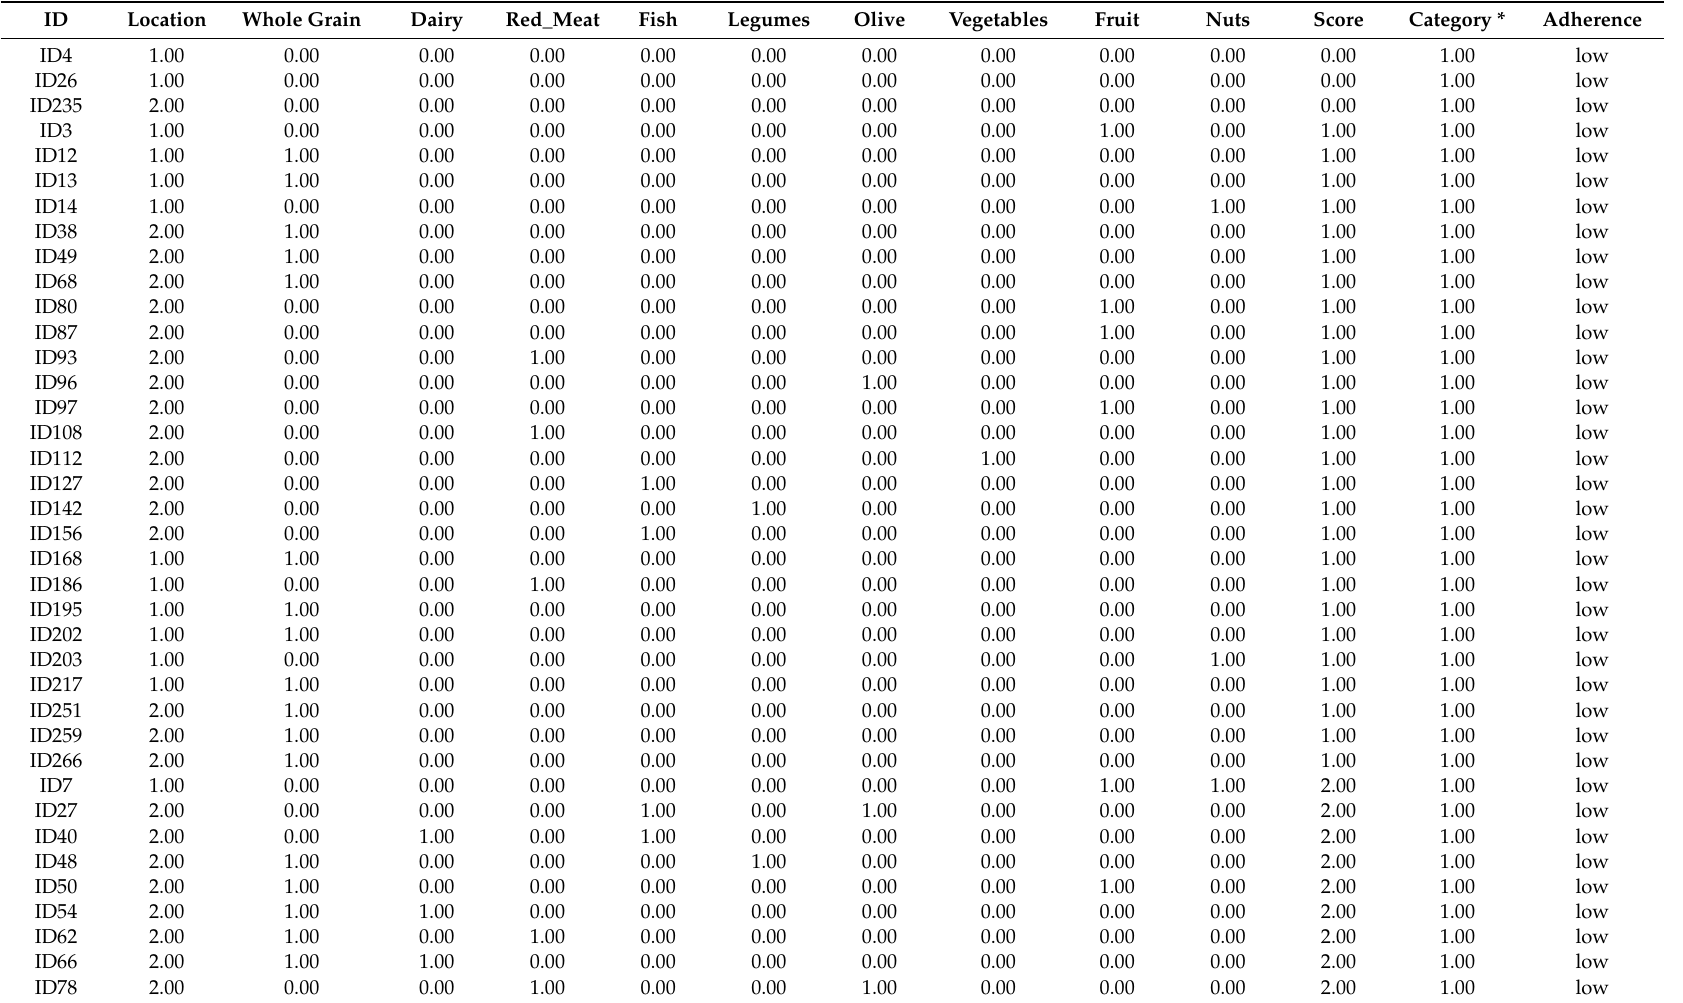
Table A2. MDS-preg score calculation according to specific food